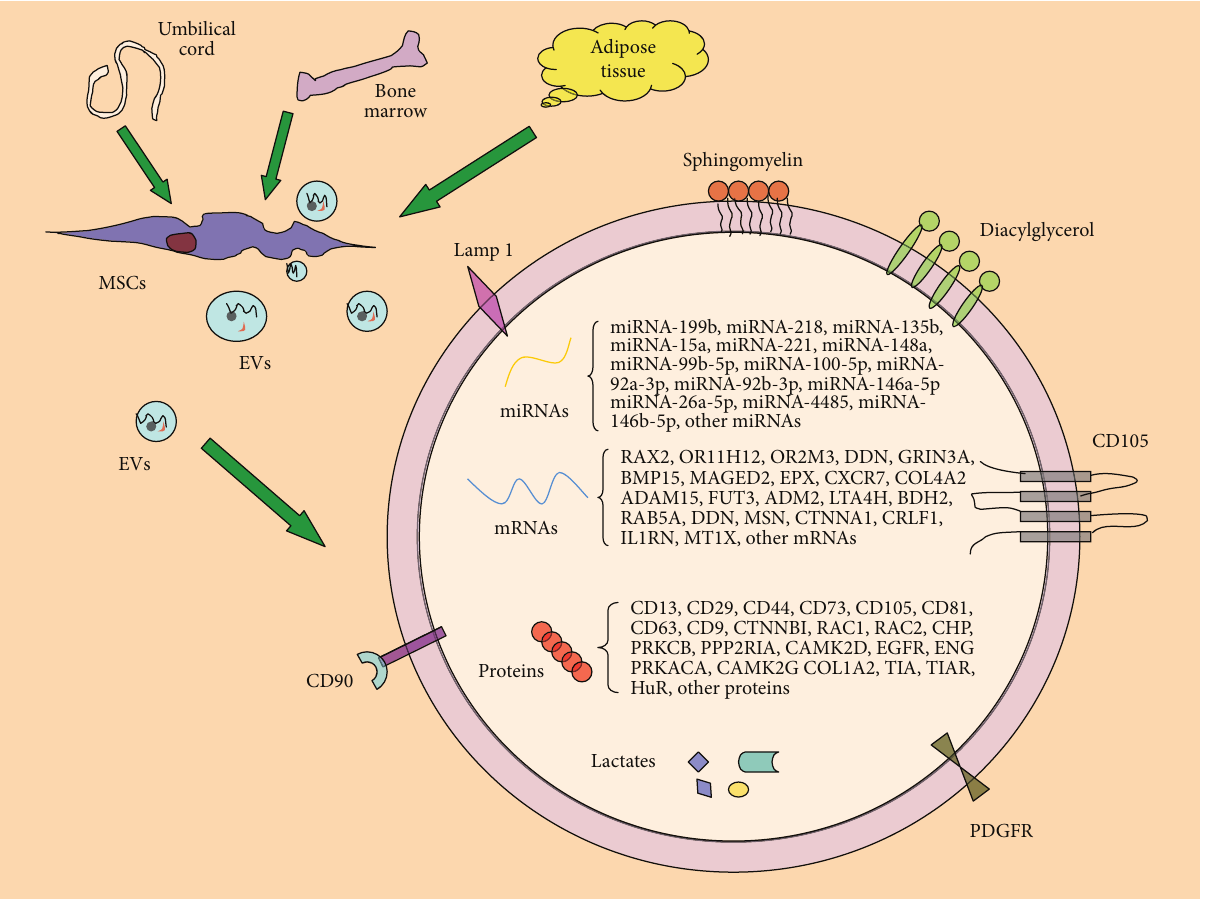
Figure 1: Composition of MSC-EVs. MSC-EVs carry a variety of molecules including proteins, mRNAs, miRNAs, and lipids. Transfer of these biological materials into adjacent or distant cells may influence the behavior of the recipient